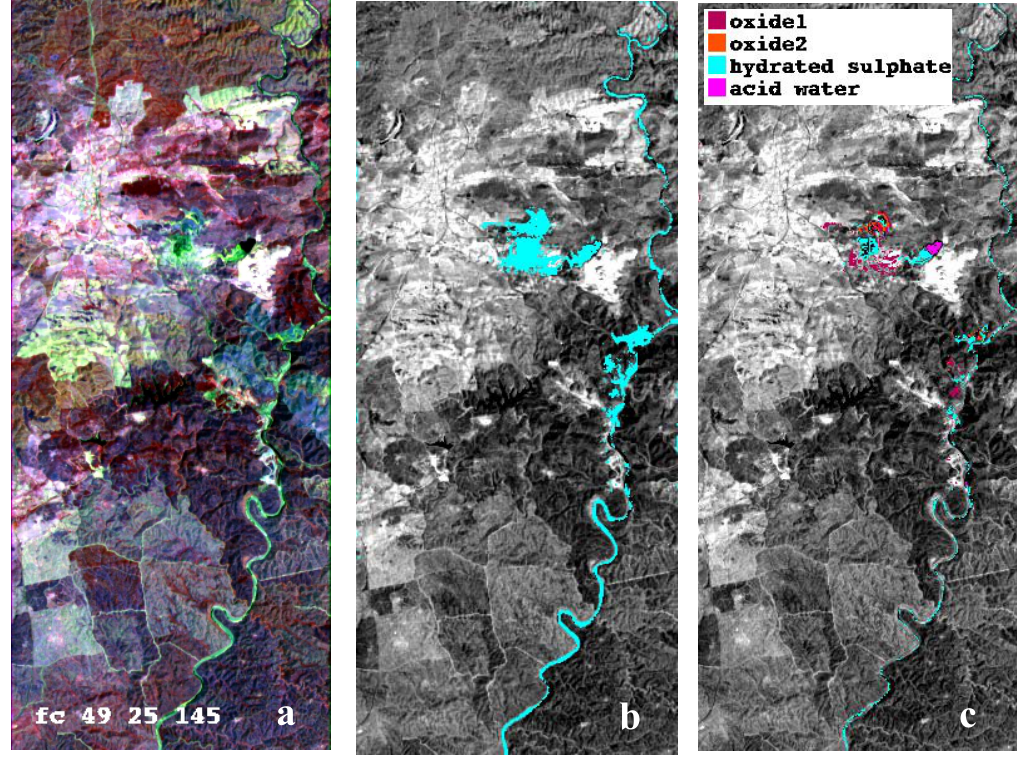
Figure 2. (a) False color composite of Hyperion data from August 2005 with channels 49 (844 nm), 25 (599, 8 nm) and 145 (1,598, 51 nm) channels. (b) Contaminated areas. (c) Map of the main contamination units at the Sotiel-Almagrera mine site and river sediments extracted from Hyperion